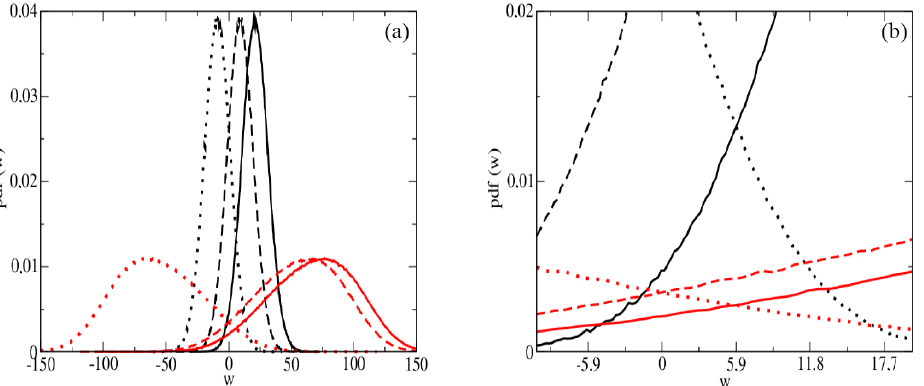
Figure 4. The forward pdf (pdf f ( z ), solid line), the backward pdf (pdf r ( z ), dashed line), and the negative of the backward pdf (pdf r ( − z ), dotted line); exp1 is in black, and exp2 is in red. Solid and dotted lines intersect at (cid:49)z = 5 . 9 as can be seen in the enlargement (b) . Exp2 is clearly non-Gaussian.